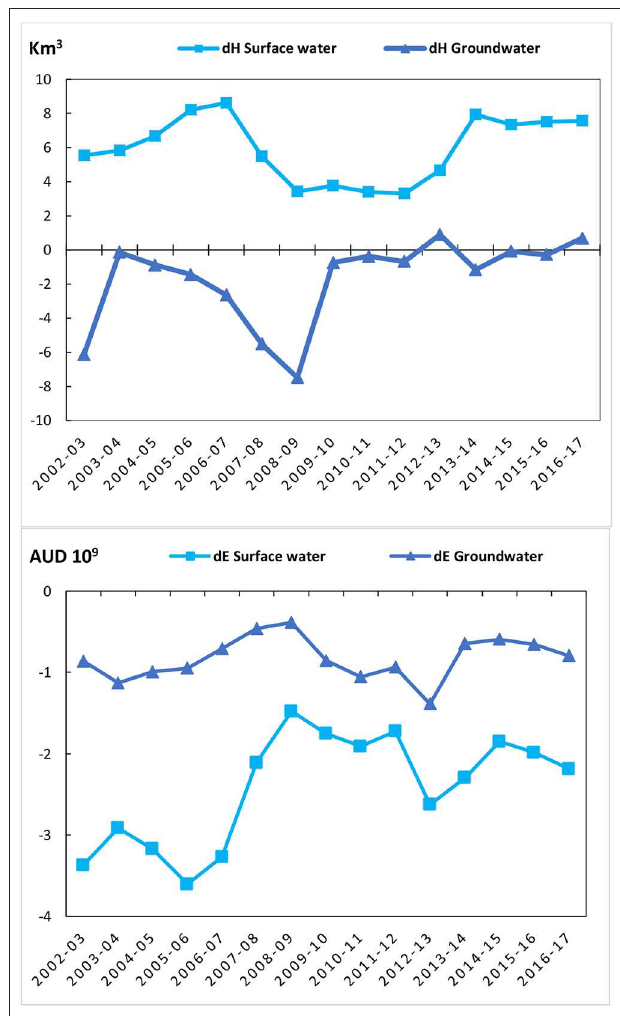
FIGURE 2 | Trend (2002–2017 period) of environmental deficit d H (km 3 ), on the left, and the socio-economic deficit d E (AUD 10 9 ), on the right at the Australian continent